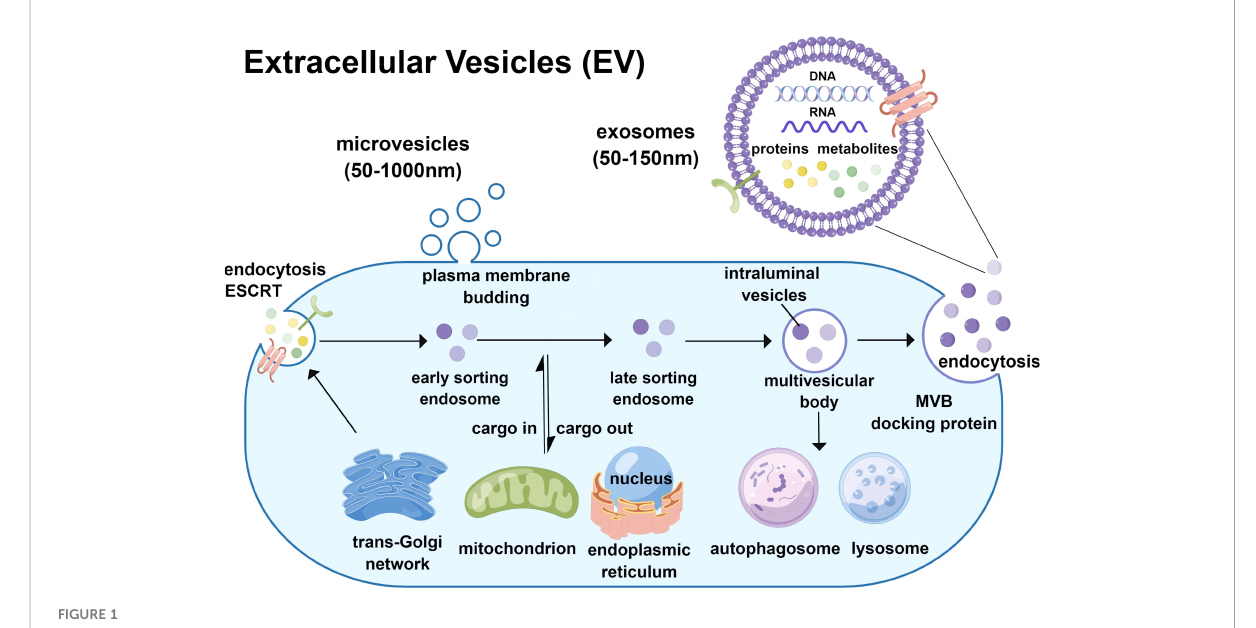
FIGURE 1 Biogenesis of exosomes and